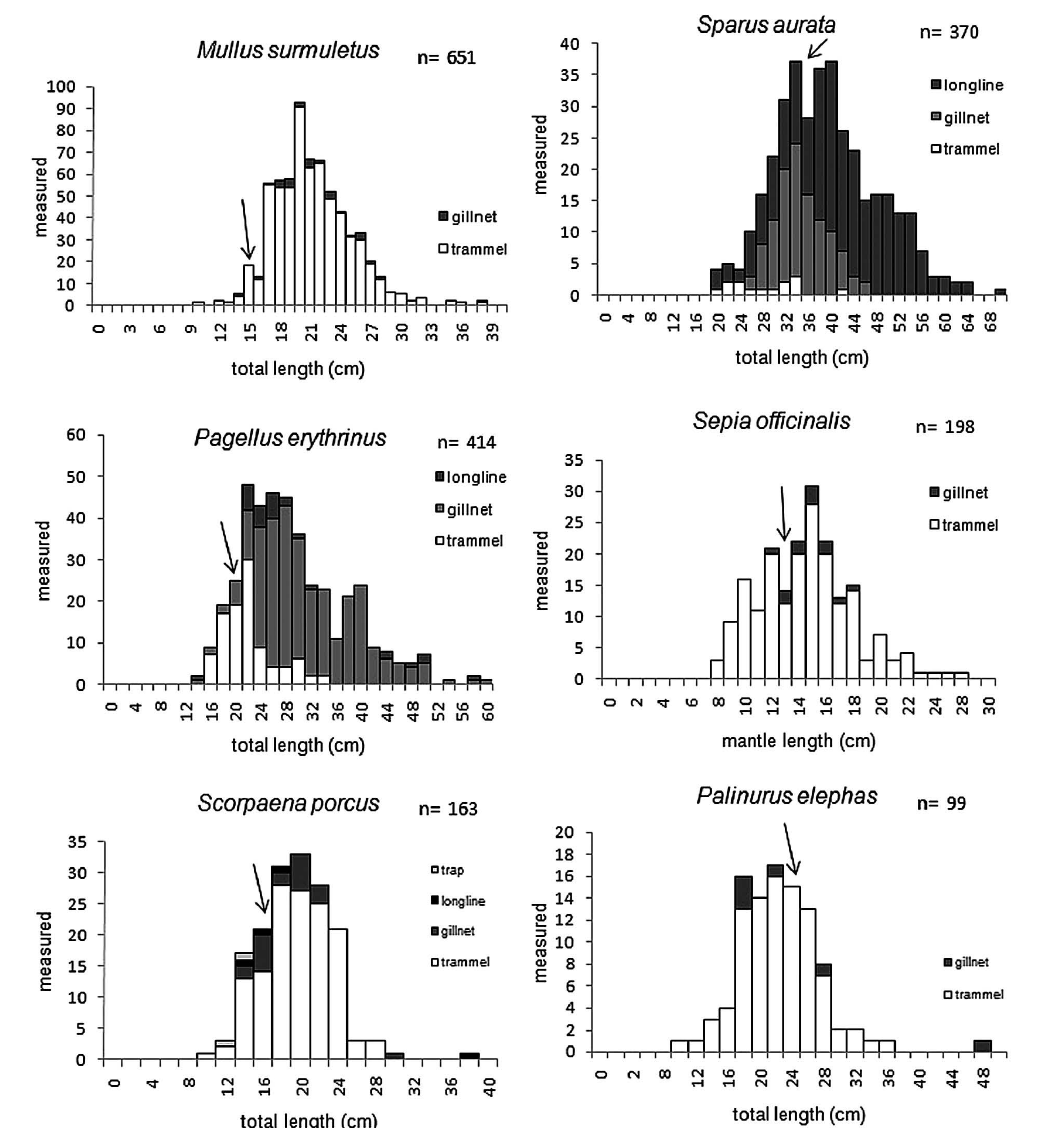
Fig. 5. – Length-frequency distributions of striped red mullet ( Mullus sumuletus ), common pandora ( Pagellus erythrinus ), gilthead seabream ( Sparus aurata ), black scorpionfish ( Scorpaena porcus ), cuttlefish ( Sepia officinalis ) and spiny lobster ( Palinurus elephas ) (all specimens measured 2004-2005, by gear; the arrow indicates the size at first